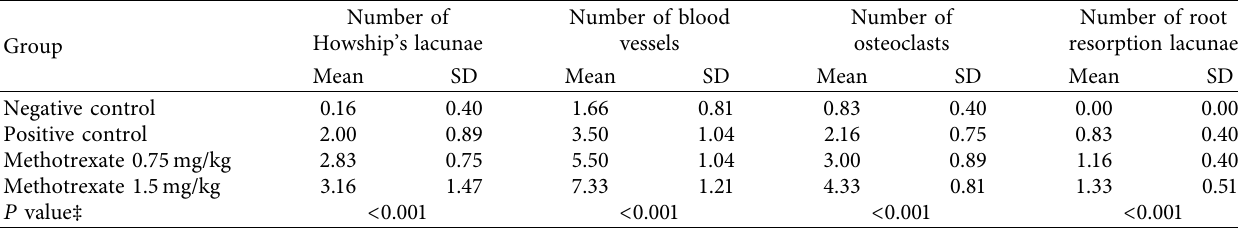
Figure 4: The result of HE staining. Blood vessels and osteoclasts in (a) negative control, (b) positive control, (c) methotrexate 0.75mg/kg, (d), and methotrexate 1.5mg/kg. Scale bar 20 µ m. Table 2: Mean and standard deviation of each histological variable in the four groups (mm 2 ).